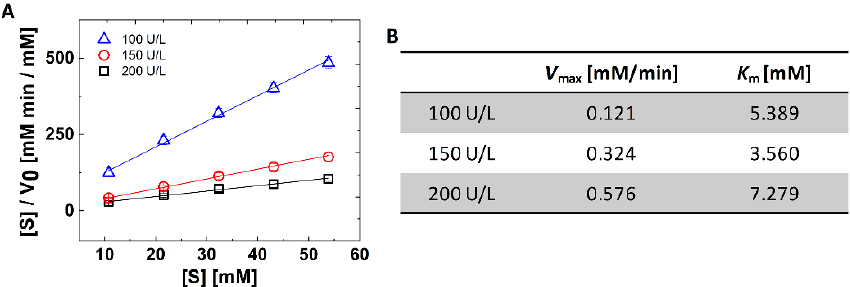
Figure 4. The concentration of p -nitrophenol was measured for 1 min to determine the initial reaction rate for the various enzyme concentrations. ( A ) 100 U/L. ( B ) 150 U/L. ( C ) 200 U/L.